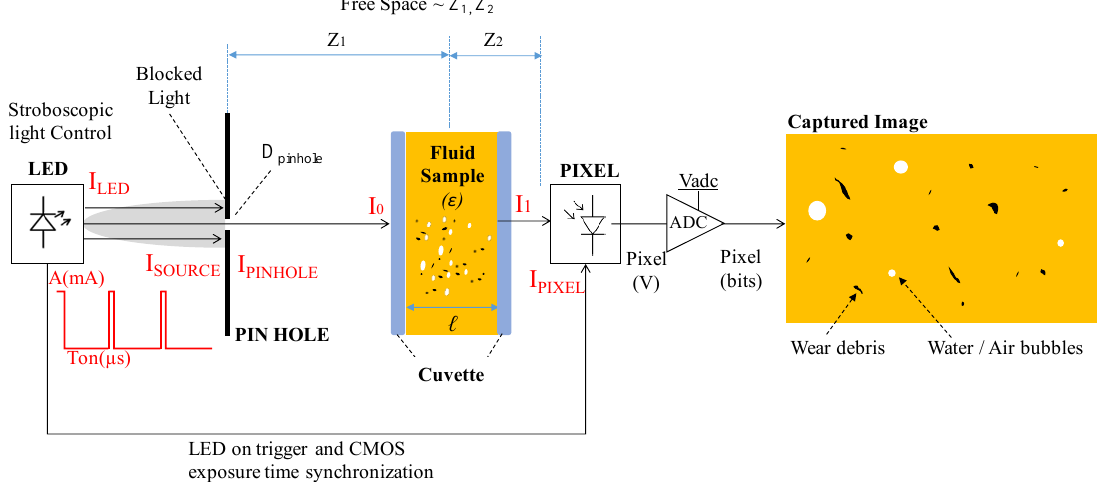
Figure 8. Block diagram depicting the main factors impacting in the light intensity detected at the CMOS sensor.